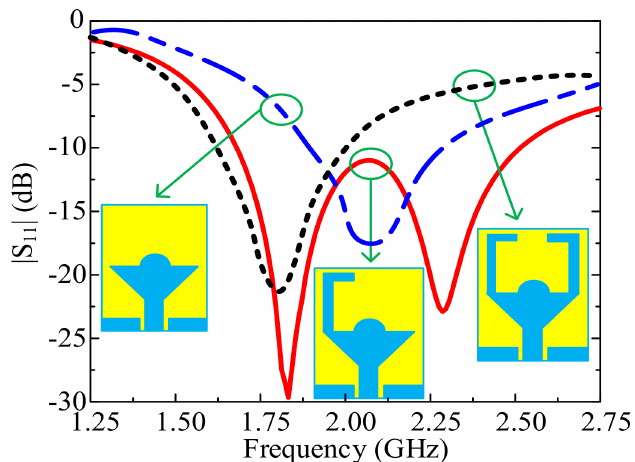
Figure 4. S-parameter comparison of various steps involved in antenna designing.